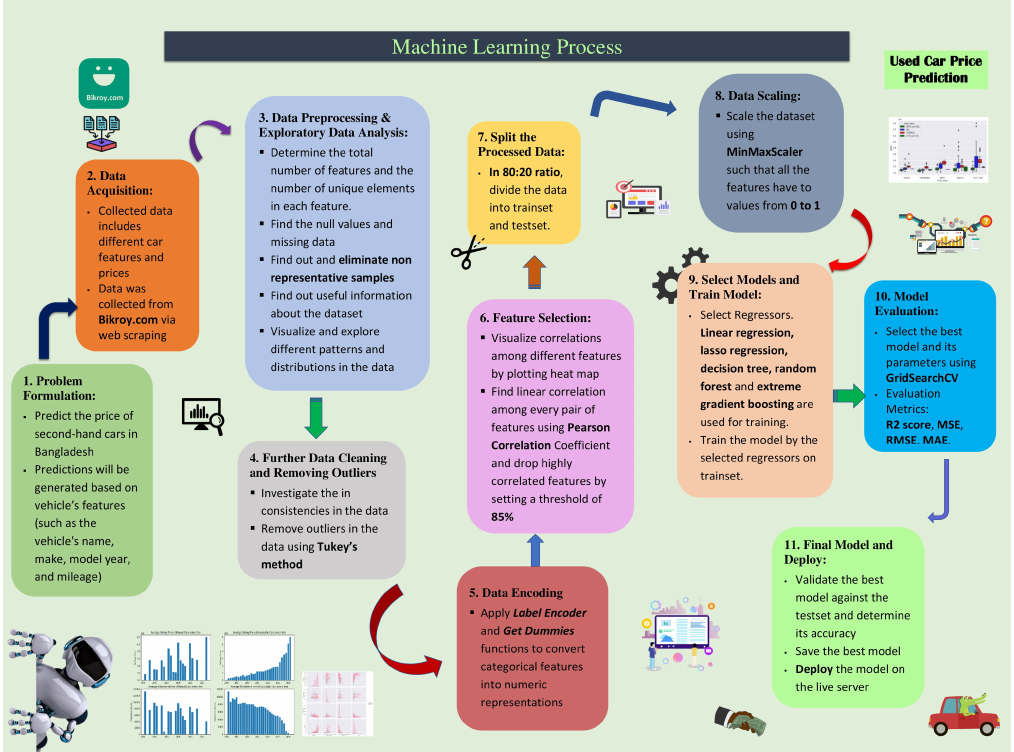
Figure 1. Flow Chart of Research